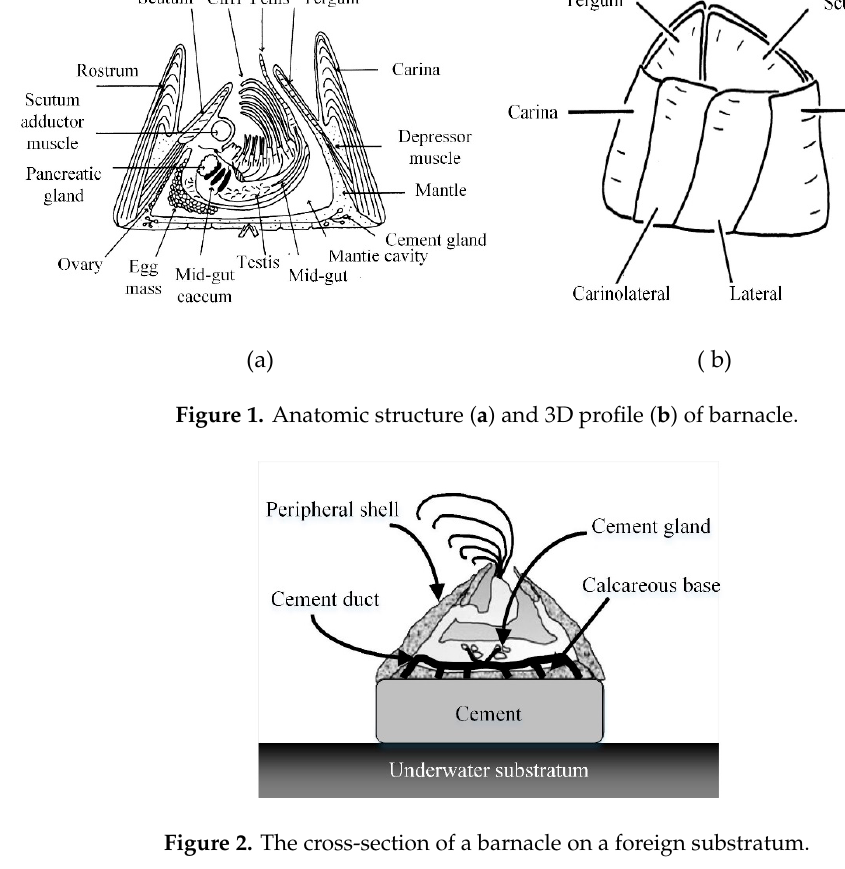
Figure 2. The cross-section of a barnacle on a foreign substratum.